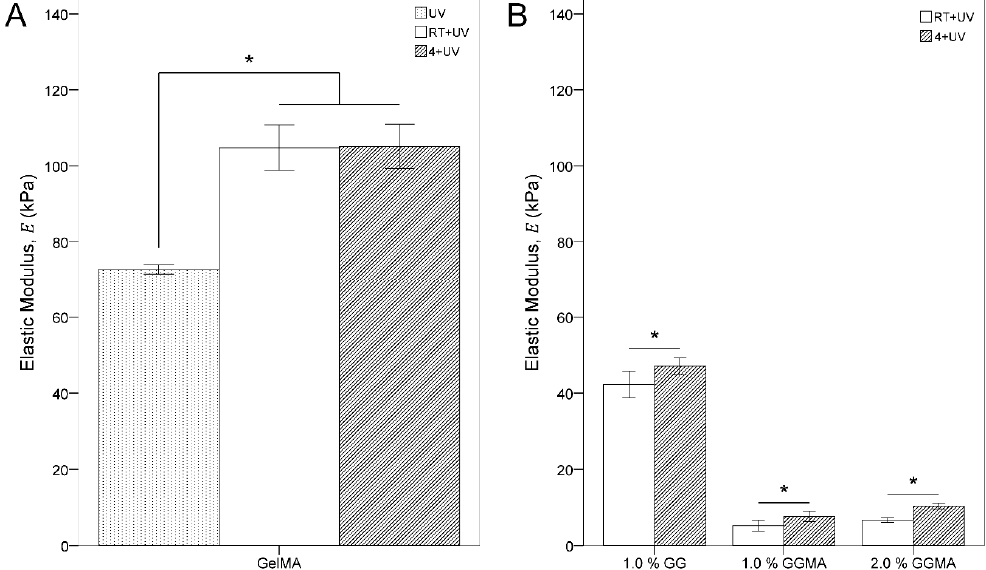
Figure 8. Comparison of elastic moduli of hydrogels with various physical crosslinking prior to ultraviolet (UV) irradiation. ( A ) GelMA gels; and ( B ) GGMA gels. Crosslinked immediately (UV; dotted bars), after setting at room temperature (RT + UV; white bars) or at 4 °C (4 + UV; cross-hatched bars) prior to UV crosslinking. IC concentration 0.05% w / v , UV dosage 1500 mJ·cm − 2 , incubation prior to UV of 20 min for RT + UV and 10 min for 4 + UV. Lines indicate groups compared using independent samples t -test, asterisks (*) indicate significant difference, p < 0.05, n = 5 in all cases. GG and GGMA were not tested with immediate UV as GG cannot crosslink through this method and no GG and GGMA would be